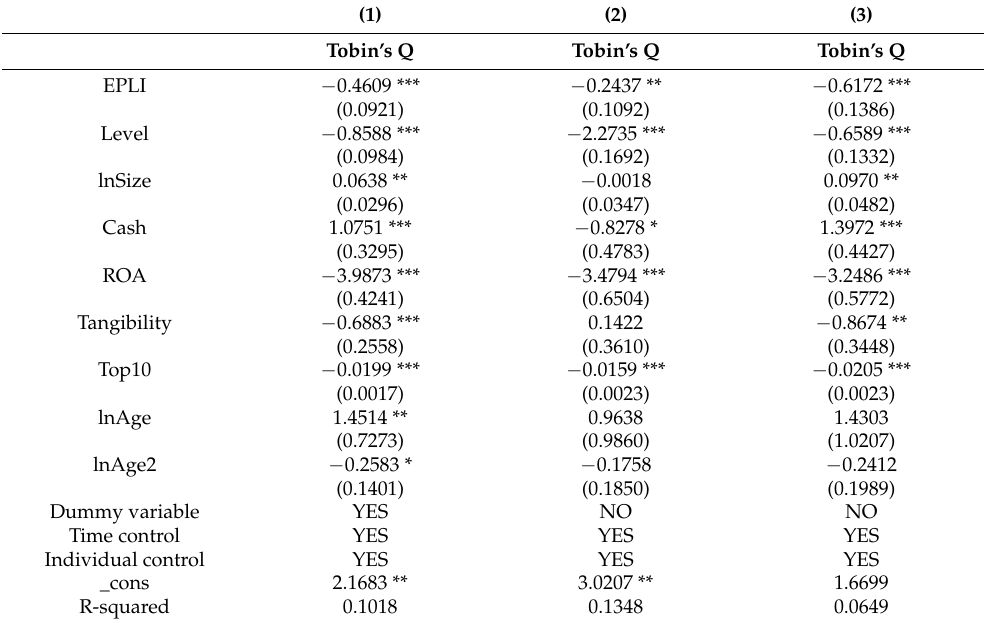
Table 8. Heterogeneity of property